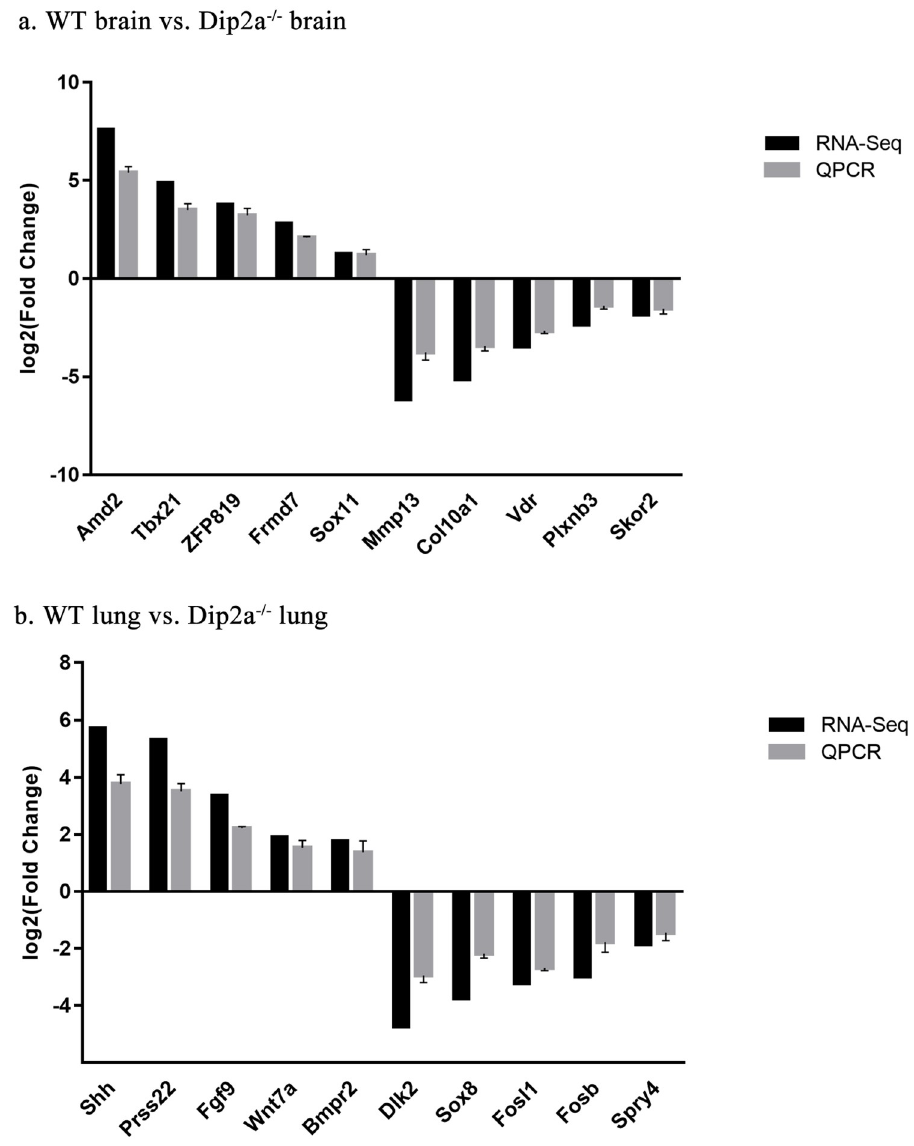
Fig 7. Validation of RNA-Seq results by real-time quantitative PCR (QPCR). These genes were down-regulated. Similarly, Frmd7 gene which promotes neuronal outgrowth and migration of neural precursor cell was up-regulated [19]. Fut10 is important in mainte- nance and differentiation of neuron stem cell and was up-regulated [20]. Extracellular matrix component Hapln1 gene that plays an important in neo-cortex development and expansion was found over expressed [21]. Transcription factor SRY-box (Sox) family gene Sox11 is expressed abundantly in all type of embryonic sensory neurons including sensory ganglion and trigeminal ganglion and promotes neuronal maturation was found up-regulated [22]. In addition, transcription factor AP-2 family gene Tfap2c important in neural crest induction was under expressed [23]. We also found Plxnb3 gene was down-regulated. Increasing evi- dence suggests that Plexin-B3 is axon guidance molecule and promotes synapse formation in